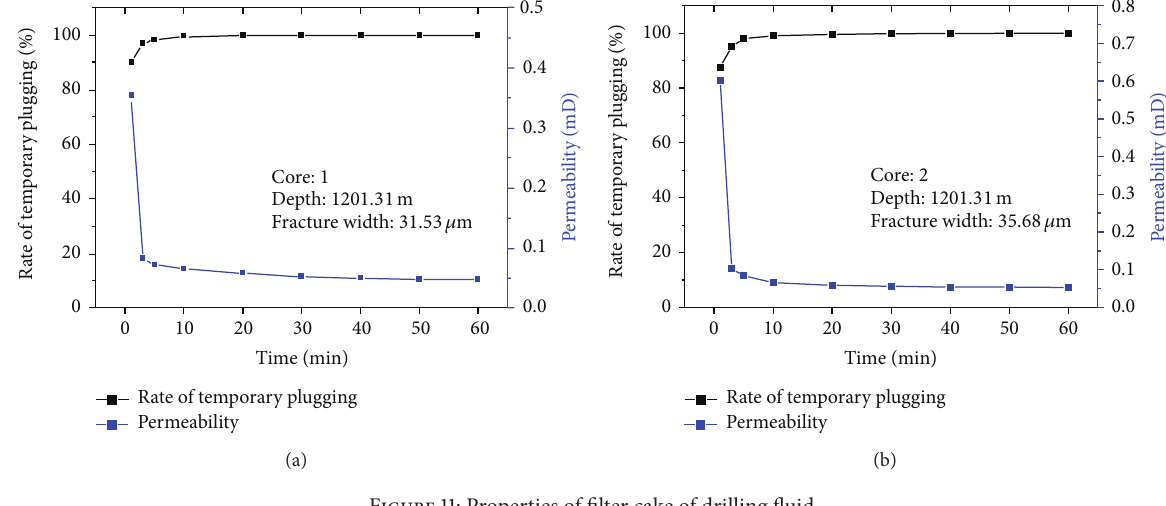
Figure 11: Properties of filter cake of drilling